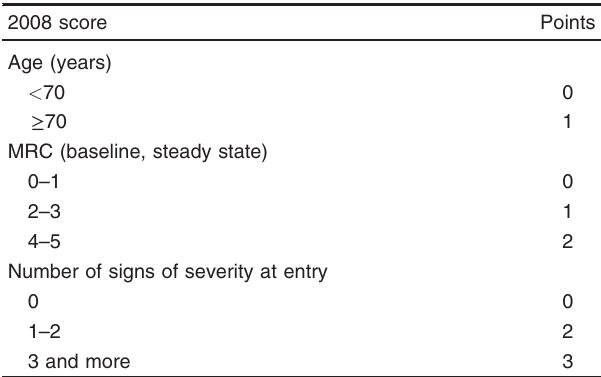
Signs of severity: cyanosis, use of accessory inspiratory muscles, paradoxical abdominal movement, asterixis, neurological impairment, and lower limb edema. MRC, Medical Research